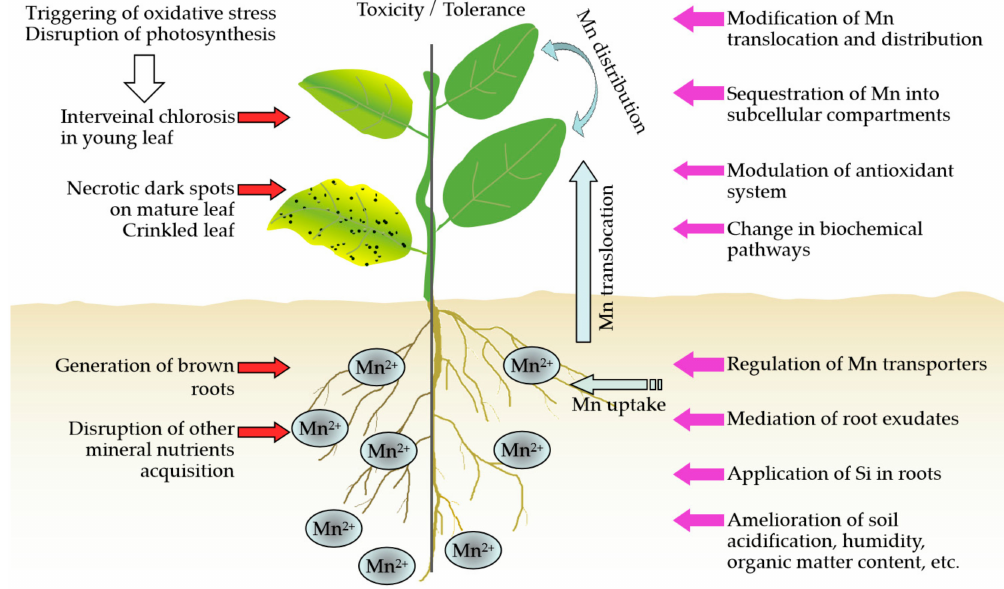
Figure 1. Schematic representation of Mn toxicity and strategies for increasing Mn tolerance in plants. Mn toxicity can trigger oxidative stress and disrupt photosynthesis, which may result in the generation of interveinal chlorosis in young leaves, necrotic dark spots on mature leaves, and crinkled leaf. Furthermore, Mn toxicity can lead to the formation of brown roots and prevent the uptake and translocation of other mineral elements. In plants, Mn tolerance strategies include modification of Mn translocation and distribution, sequestration of Mn into subcellular compartments, modulation of the antioxidant system, changes in biochemical pathways, and regulation of Mn transporters. In addition, the mediation of root exudates, the application of Si in roots, and the amelioration of soil acidification, humidity, and organic matter content also contribute to increase plant Mn tolerance. Red arrows indicate the toxic e ff ects of excess Mn to plants. Purple arrows represent the adaptive strategies of plants to Mn